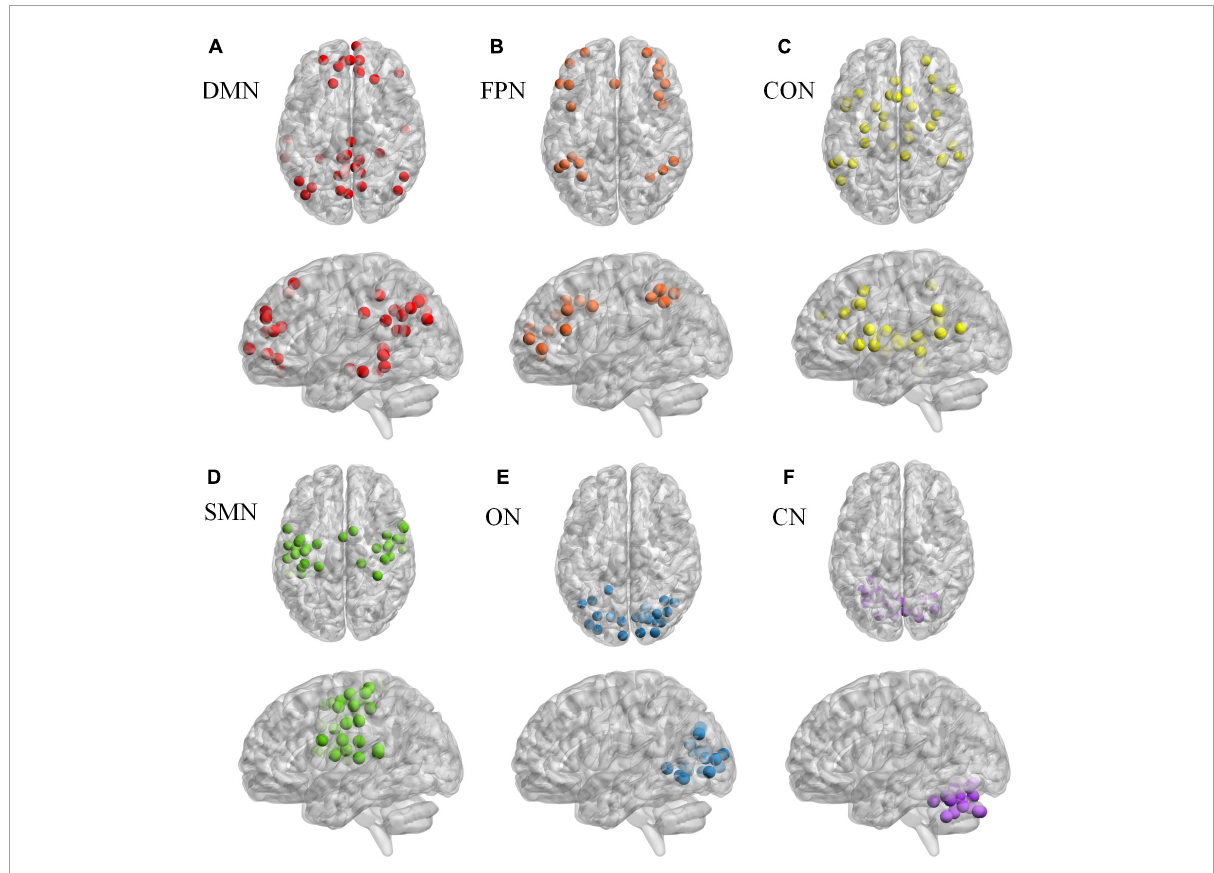
FIGURE1 The Dosenbach 160 atlas includes 160 brain regions, which are classified into 6 sub-networks including Default Mode Network (A) , Fronto-parietal Network (B) , Cingulo-opercular Network (C) . Sensorimotor Network (D) , Occipital Network (E) , and Cerebellum Network (F) .